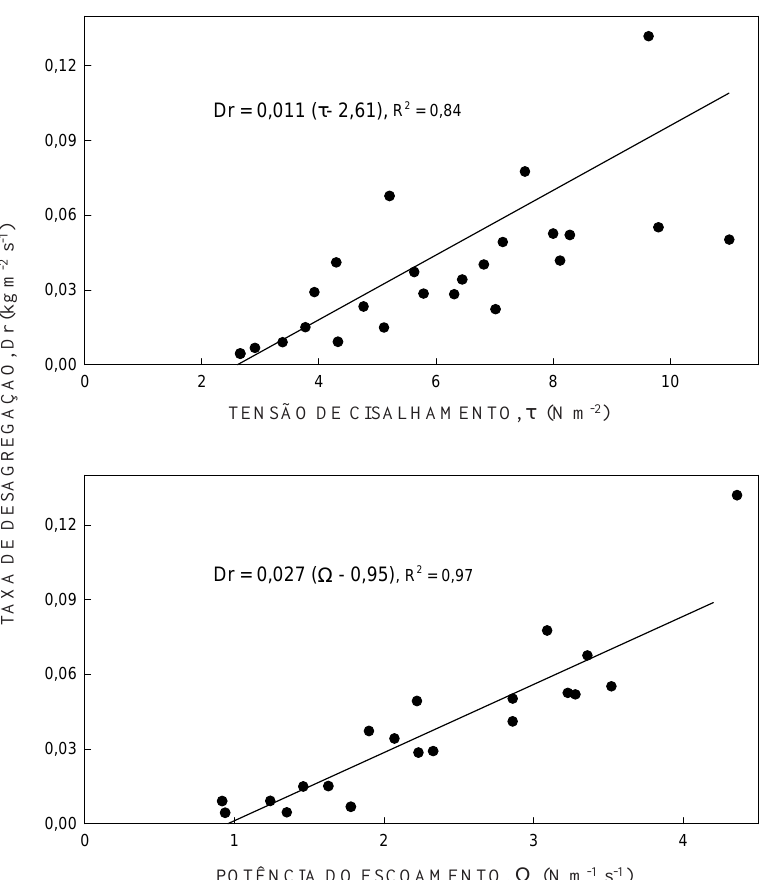
Figura 5. Relações entre taxa de desagregação (Dr) com tensão cisalhante ( ttttt ) e potência ( WWWWW ) do escoamento para o tratamento convencional recente. Usaram-se somente as repetições cujo valores críticos de tensão cisalhante ou potência do escoamento foram